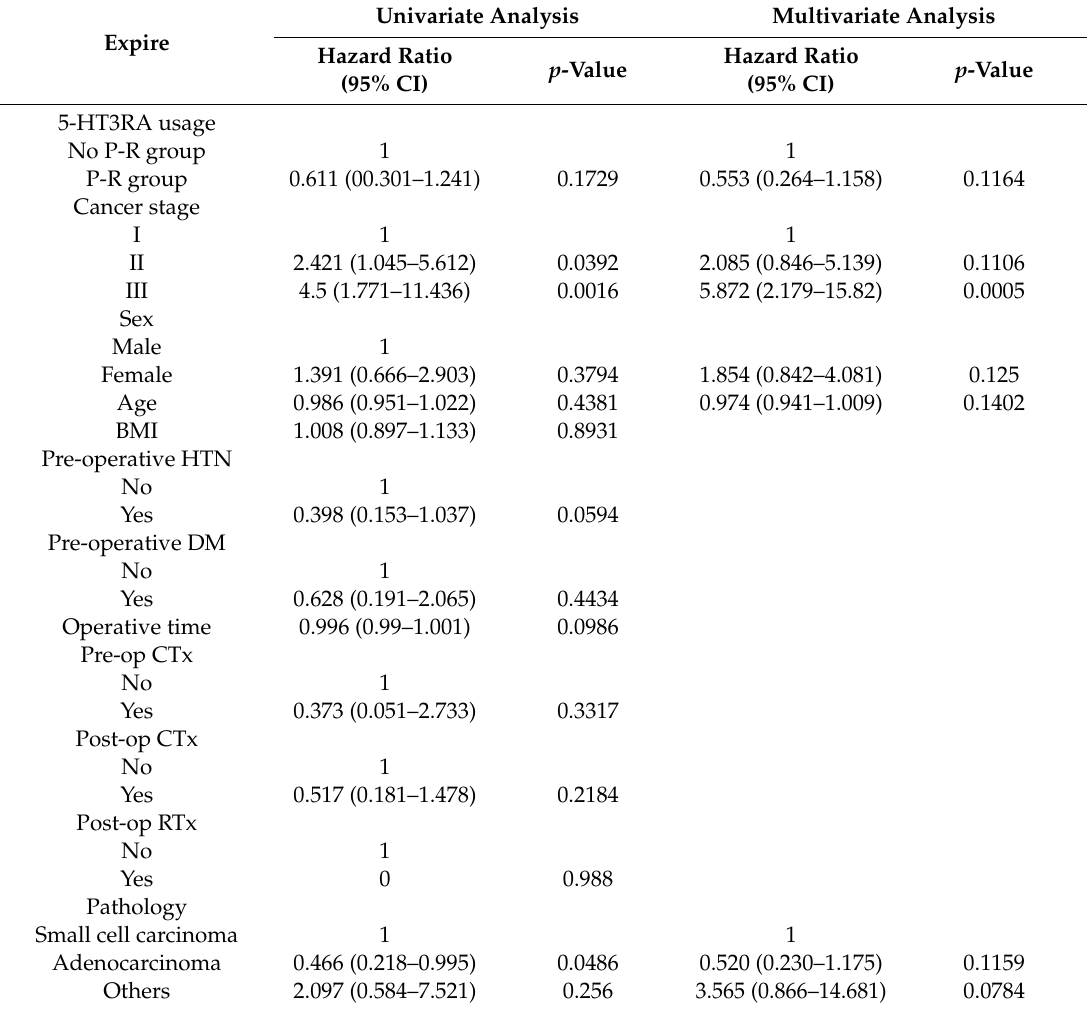
Table 3. Univariate and multivariate regression analysis of variables after propensity score matching with expire rate after open lung surgery for lung